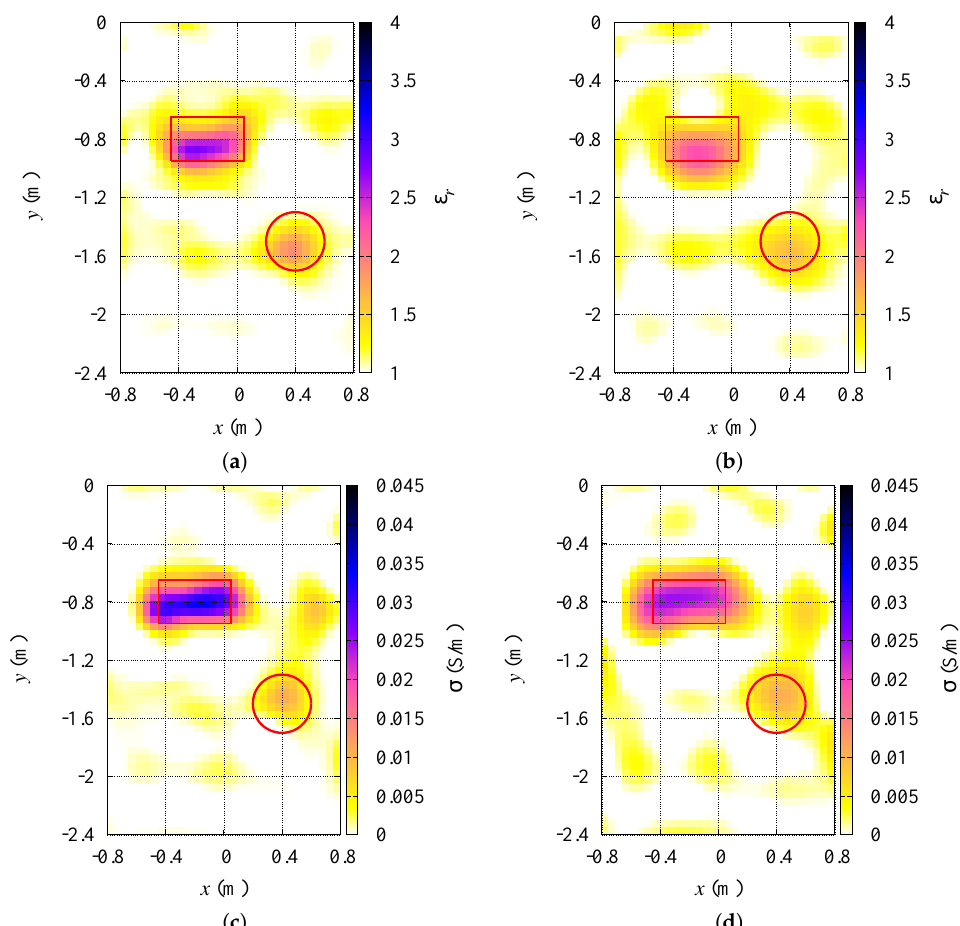
Figure 6. Multiple targets in the investigation area. Reconstructed distributions of the dielectric properties inside the investigation region: ( a ) relative dielectric permittivity, p = 1.4; ( b ) relative dielectric permittivity, p = 2; ( c ) electric conductivity, p = 1.4; ( d ) electric conductivity, p =